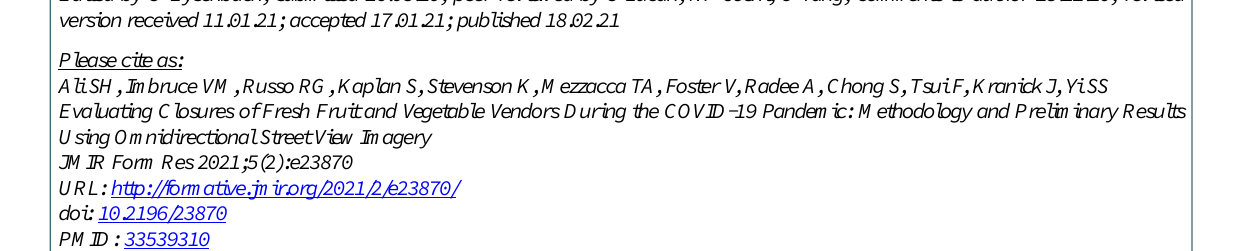
Evaluating Closures of Fresh Fruit and Vegetable Vendors During the COVID-19 Pandemic: Methodology and Preliminary Results Using Omnidirectional Street View